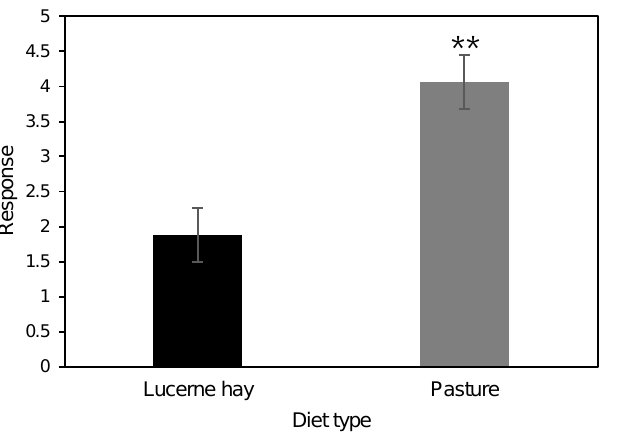
Figure 2. Olfactory responses of B. bison to fresh dung collected from horses fed on lucerne hay and fresh pasture ( n = 96 beetles) (**, p < 0.01 as determined by Wilcoxon’s signed -rank test).